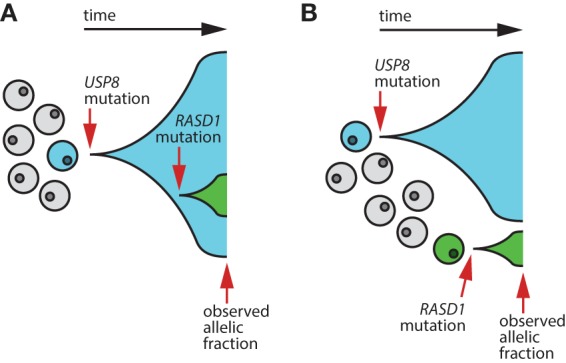
Two models that explain the observed allelic fractions of the USP8 and RASD1 somatic mutations. (A) Mutation RASD1 p.K34M occurs in a single cell derived from the clonal expansion of USP8-mutant cells. (B) Mutation RASD1 p.K34M occurs in an independent, USP8-wild-type cell and undergoes clonal expansion separate from the USP8-mutant clonal expansion.